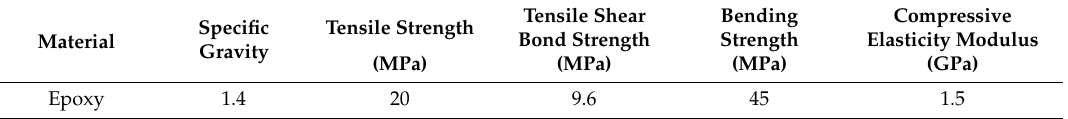
Table 4. Material properties of the